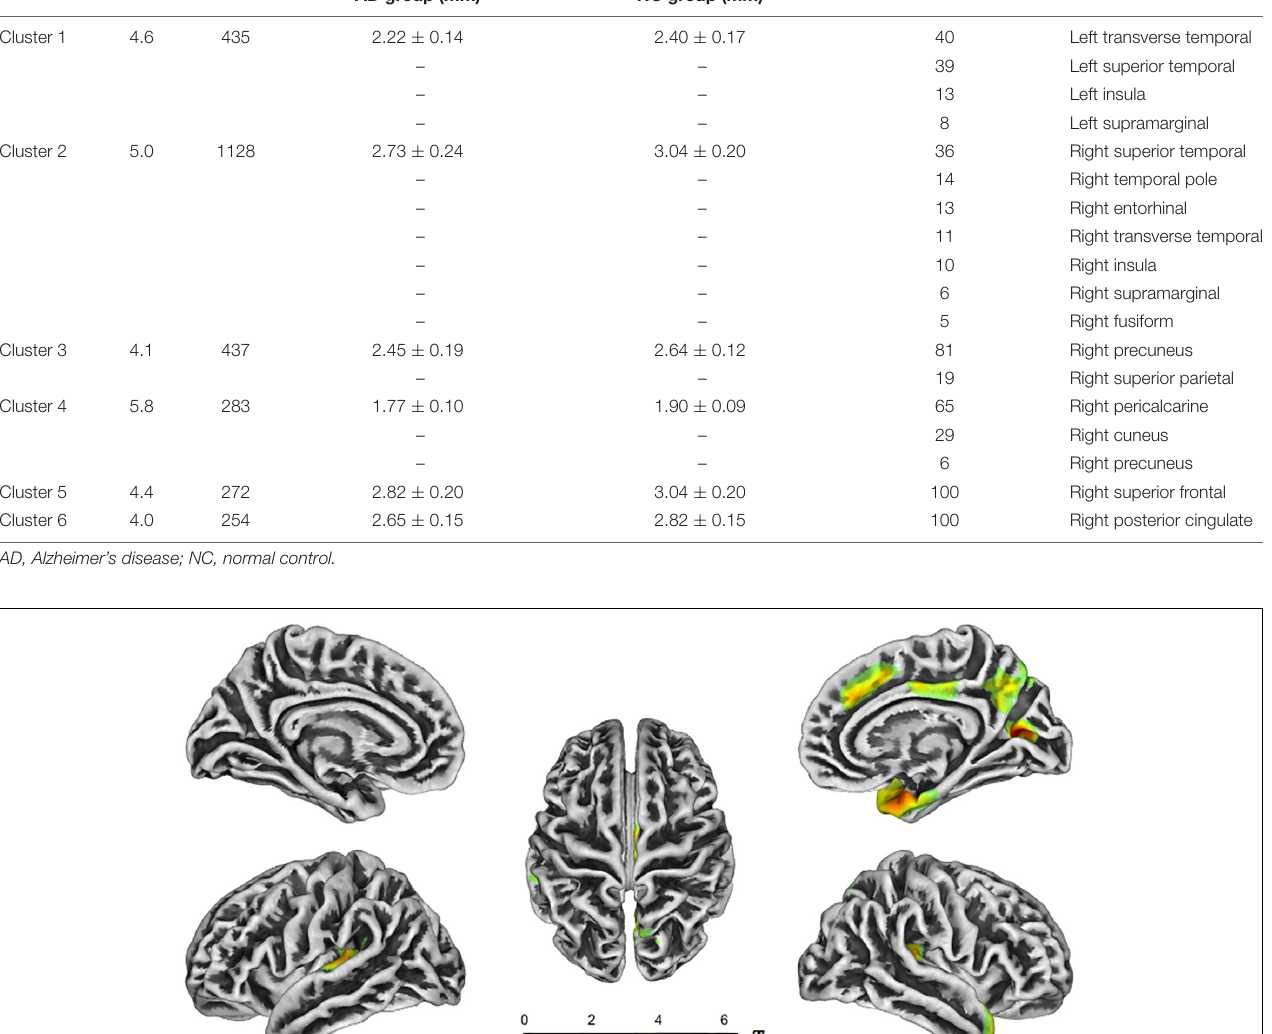
thickness decreased, the plasma A β 40, A β 42, and P-Tau values increased. See Table 5 for